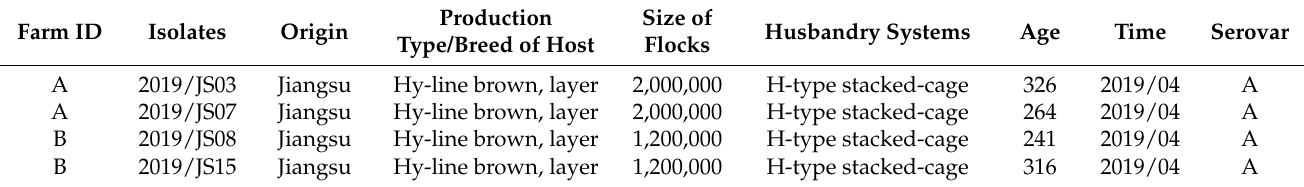
Table 1. Origin of Avibacterium paragallinarum